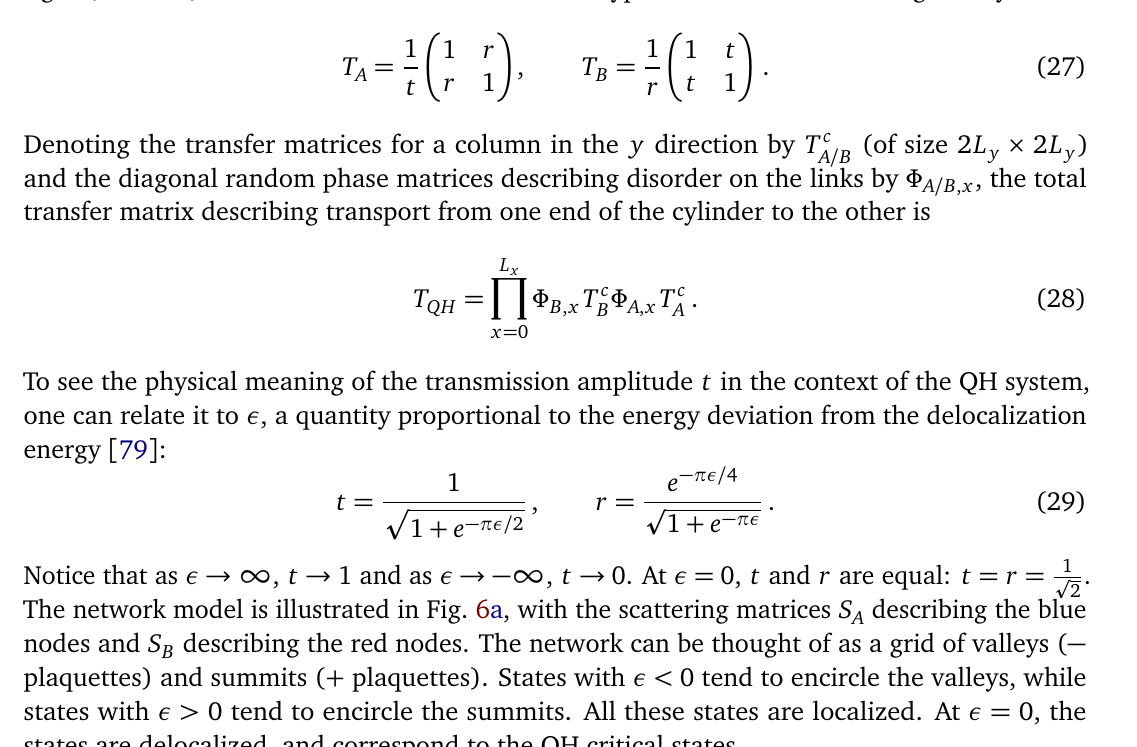
Figure 6: a) A schematic of the network model. Blue nodes host scattering matrices S and red nodes host scattering matrices S A random U ( 1 ) phases. States with ε ≷ 0 tend to circle around the + / − plaquettes. The state with ε = 0 is delocalized. b). In the coupled network model, we add a second layer with switched colors and opposite arrows. We also add inter-layer nodes that scatter between the two networks, indicated by the dotted